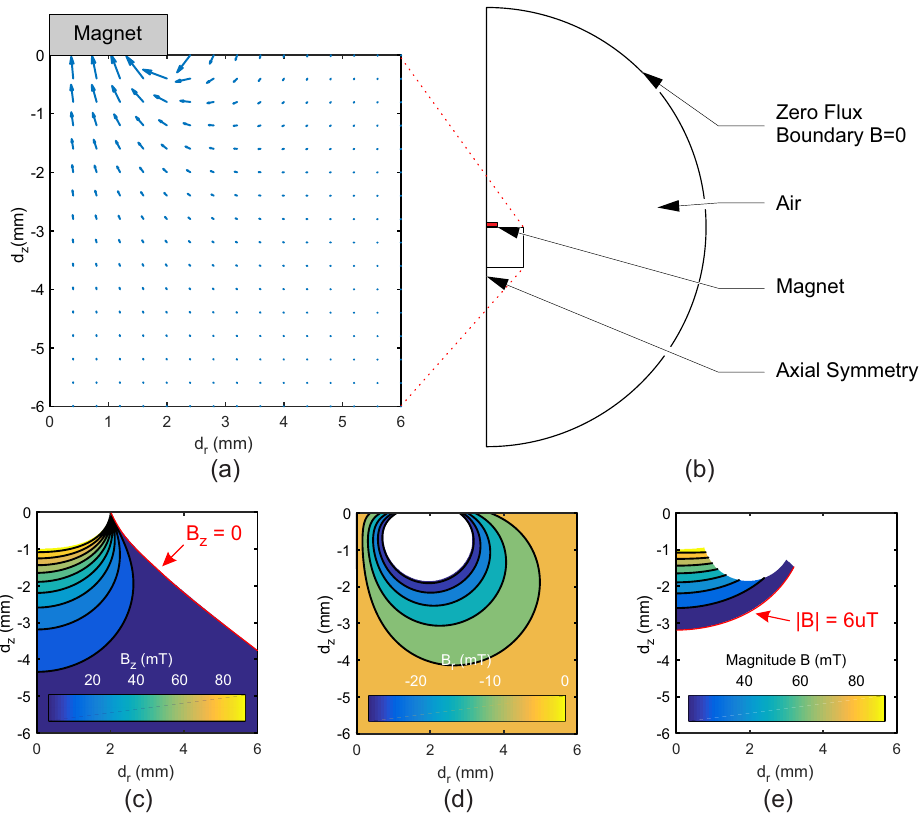
Figure 3. ( a ) Magnetic field vectors in an area of 6 × 6 mm below the simulated magnet, used in the measurable area definition; ( b ) Geometry of the magnetic field simulation, indicating the domains and boundary conditions used; Areas of sensitivity in which the Hall effect sensor is in range in ( c ) B z (also indicating the inversion line where B z = 0); ( d ) B r ; and ( e ) Combined limits, magnitude (indicating the minimum accepted field magnitude at 6 uT). d z and d r represent the vertical and horizontal movement of the magnet, respectively. d r = 0 is the axis of rotational symmetry of the disc